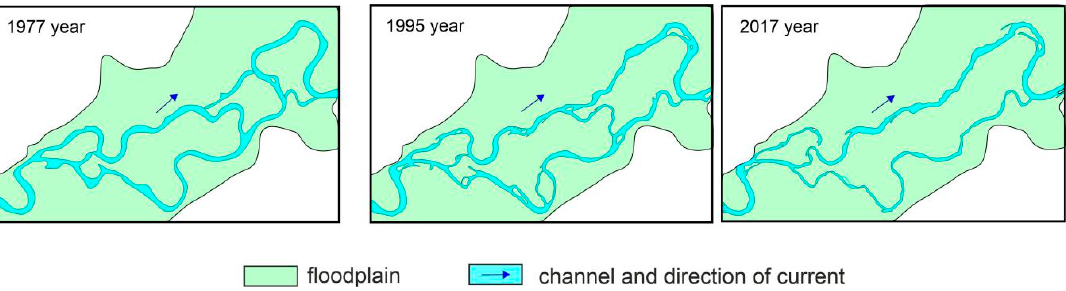
Figure 10. The most dynamic stretches of the Irkut channel (Maksimovshchina—the mouth).